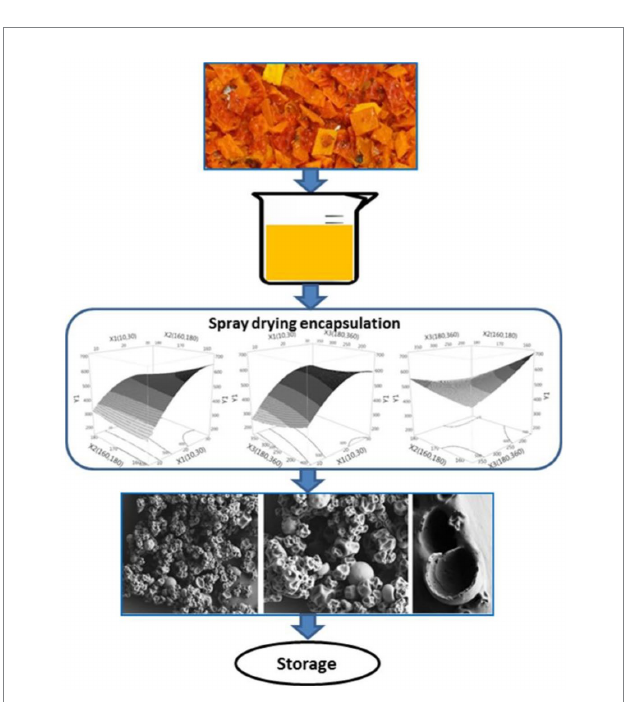
FIGURE 5 Encapsulation process of carotenoids (80).